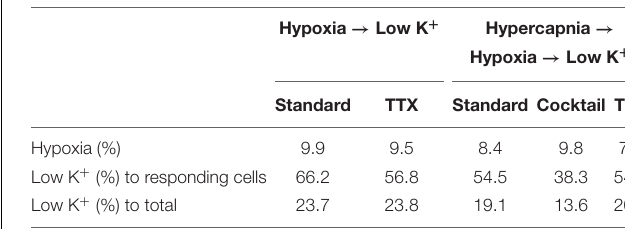
TABLE 2 | Effects of preceding treatments on responses to hypoxic stimulation and low K +